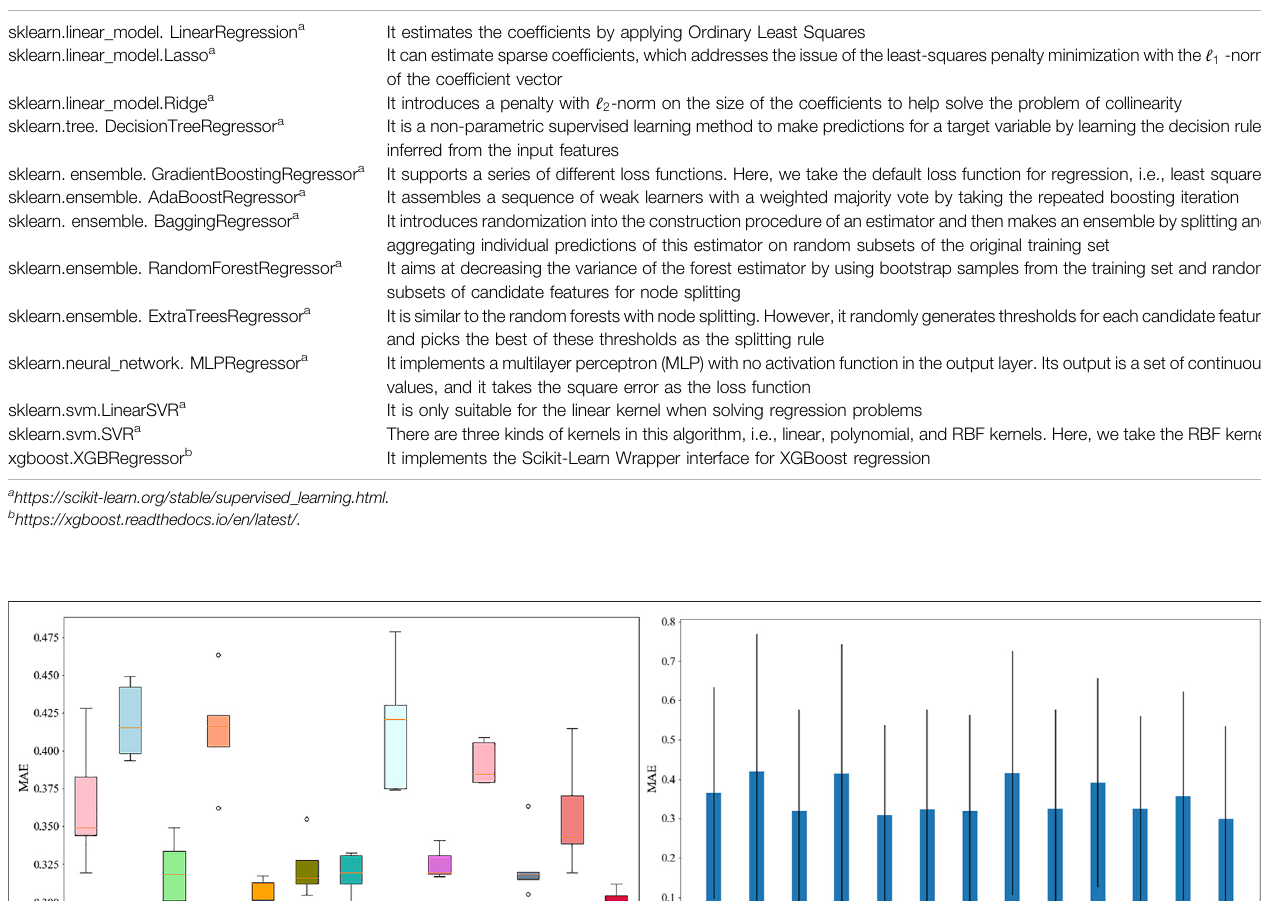
TABLE 2 | The list of 13 methods from Scikit-learn. Name